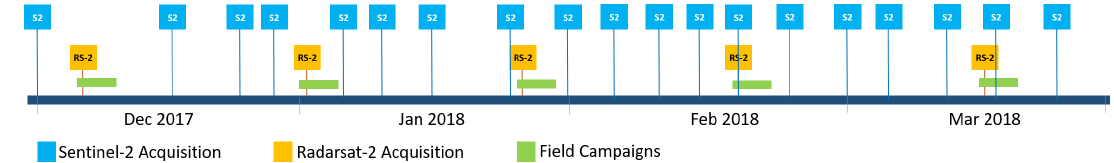
Figure 2. Calendar of the Sentinel-2 and RADARSAT-2 data acquisitions along with field campaigns over the test site.